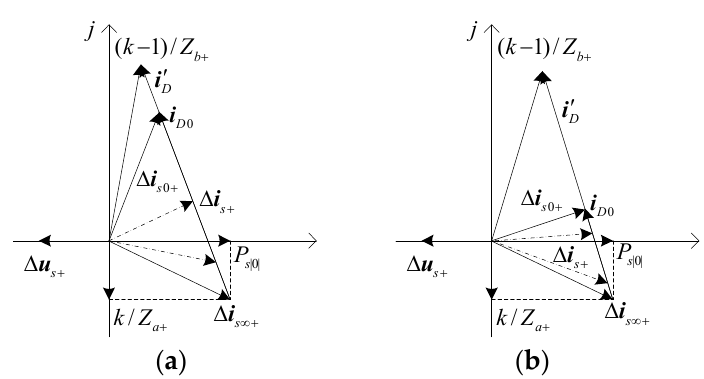
Figure 6. Vector diagram of w =0 s (3) .